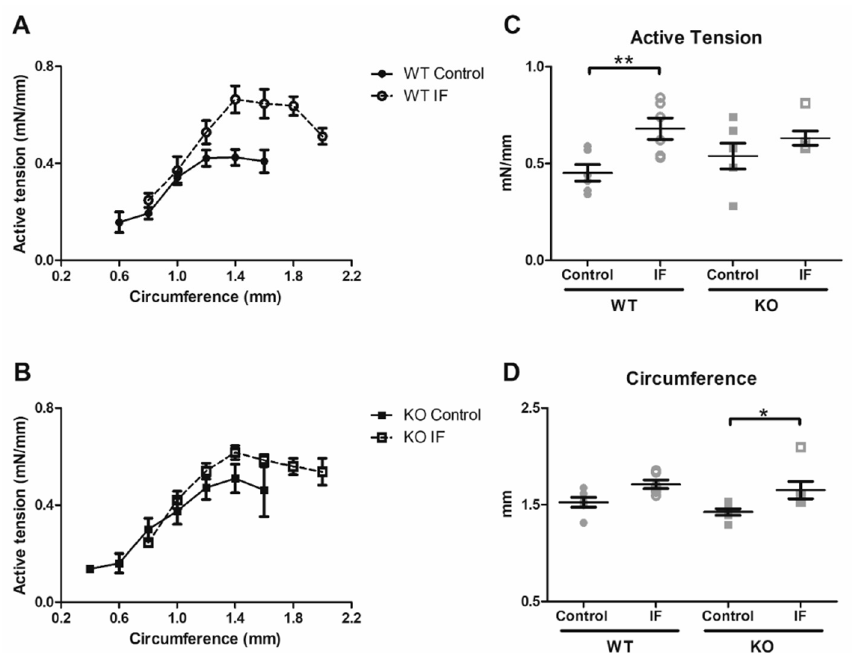
Figure 2. Impact of PCSK6 on vascular physiology measured by wire myography. Measurements of active tension at increasing circumferences categorized in intervals of 0.2 mm in ( A ) WT (control n = 4, IF n = 6) and ( B ) KO (control n = 4, IF n = 6) mice. Comparison to controls revealed an increase in ( C ) active tension at ( D ) optimal circumference in the WT mice exposed to increased blood flow, which was not observed in the KO mice. * p < 0.05, ** p < 0.01 calculated using Kruskal–Wallis test with Dunn´s test for multiple comparison. Data expressed as mean ± standard error of mean. CCA = common carotid artery. IF = increased blood flow. KO = Pcsk6 − / − mice. WT = C57Bl / 6J mice. Table 2. Wire myography parameters.